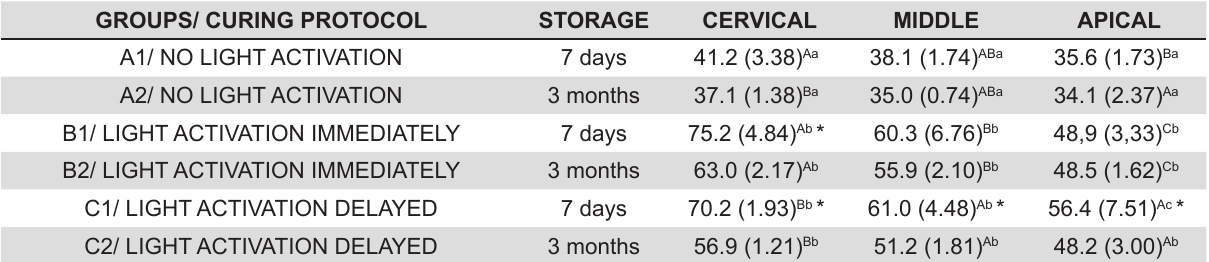
* indicates significant differences between storage periods for the same group (subgroups 1 and 2). Identical capital letters indicate no significant differences among thirds for the same curing protocol (p>.05). Identical lower cases indicate no significant differences among curing protocols within each third Table 2- Knoop hardness number (KHN) standard deviation for U100 cement according to conditions tested